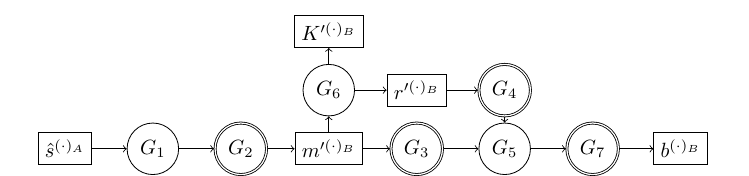
Figure 4: The gadgets considered in the proof of Theorem 3. t -NI gadgets are depicted with a single circle, t -SNI gadgets are depicted with a double